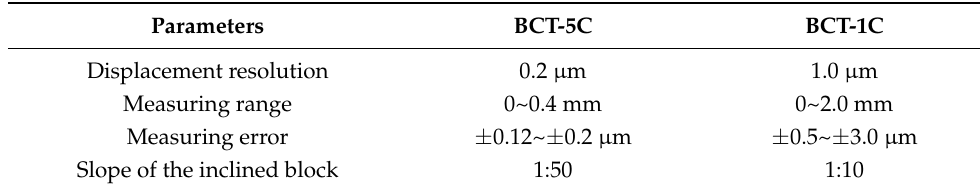
Table 2. Micro ‐ displacement measuring mounts.